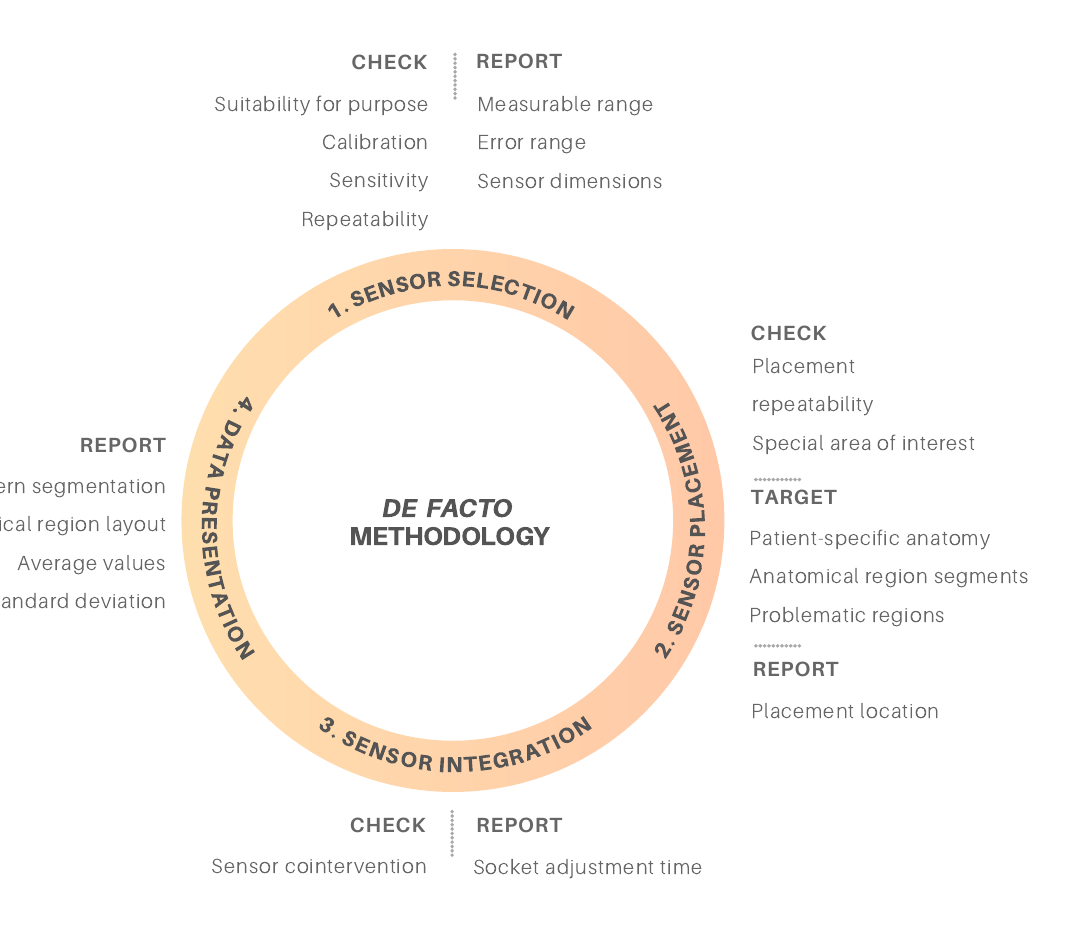
Figure 2. Suggested de facto